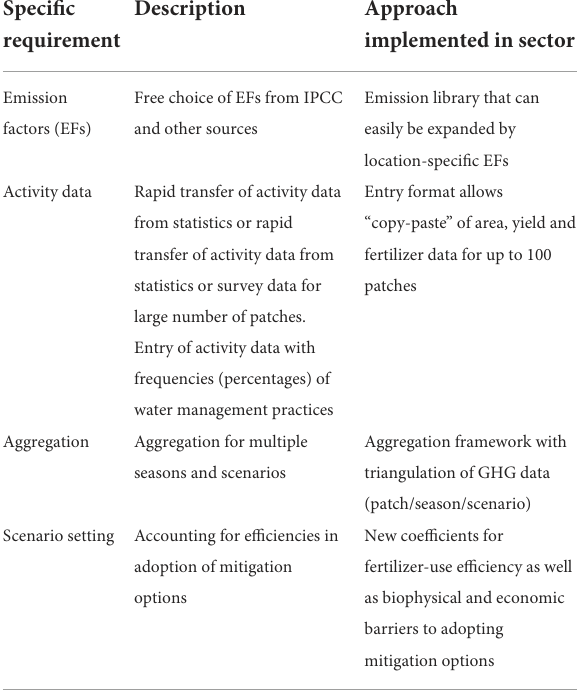
TABLE 6 Overview of specific Tier 2 requirements for GHG calculations in cropland within mitigation projects and approach in